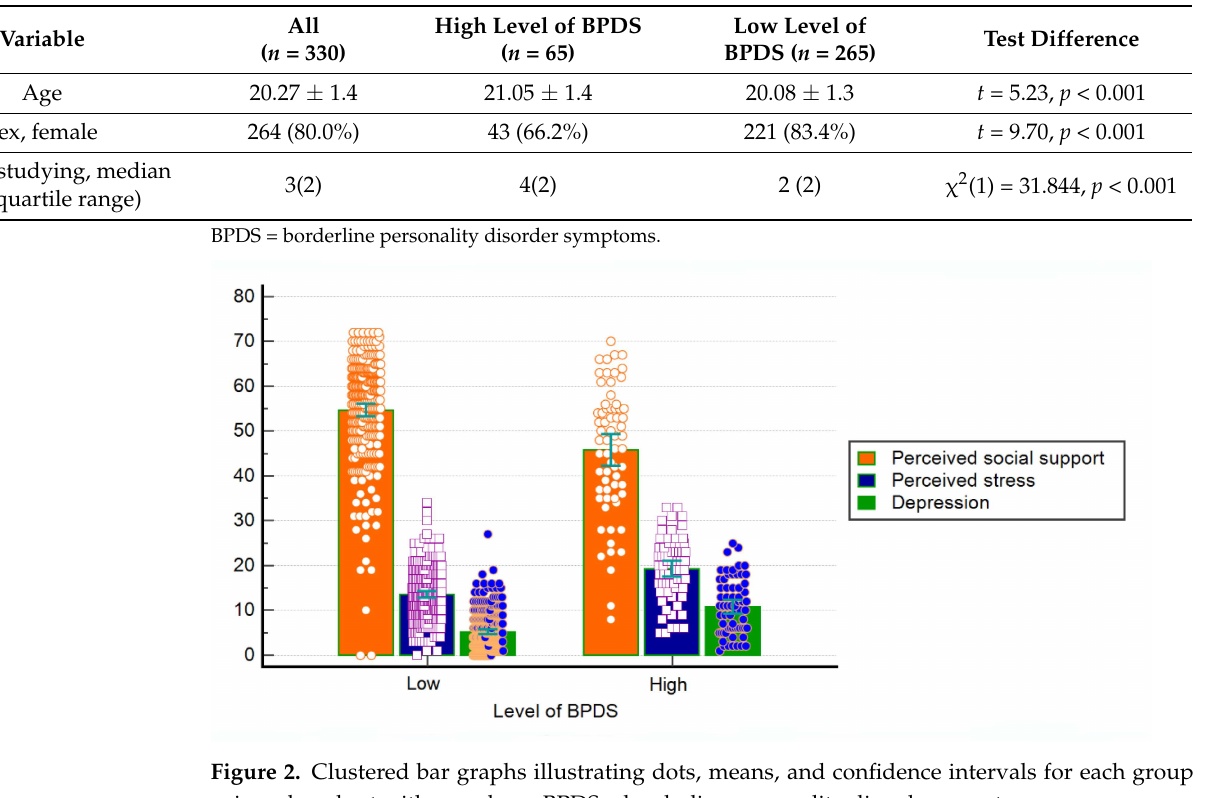
Table 1. Participants’ characteristics ( n = 330).